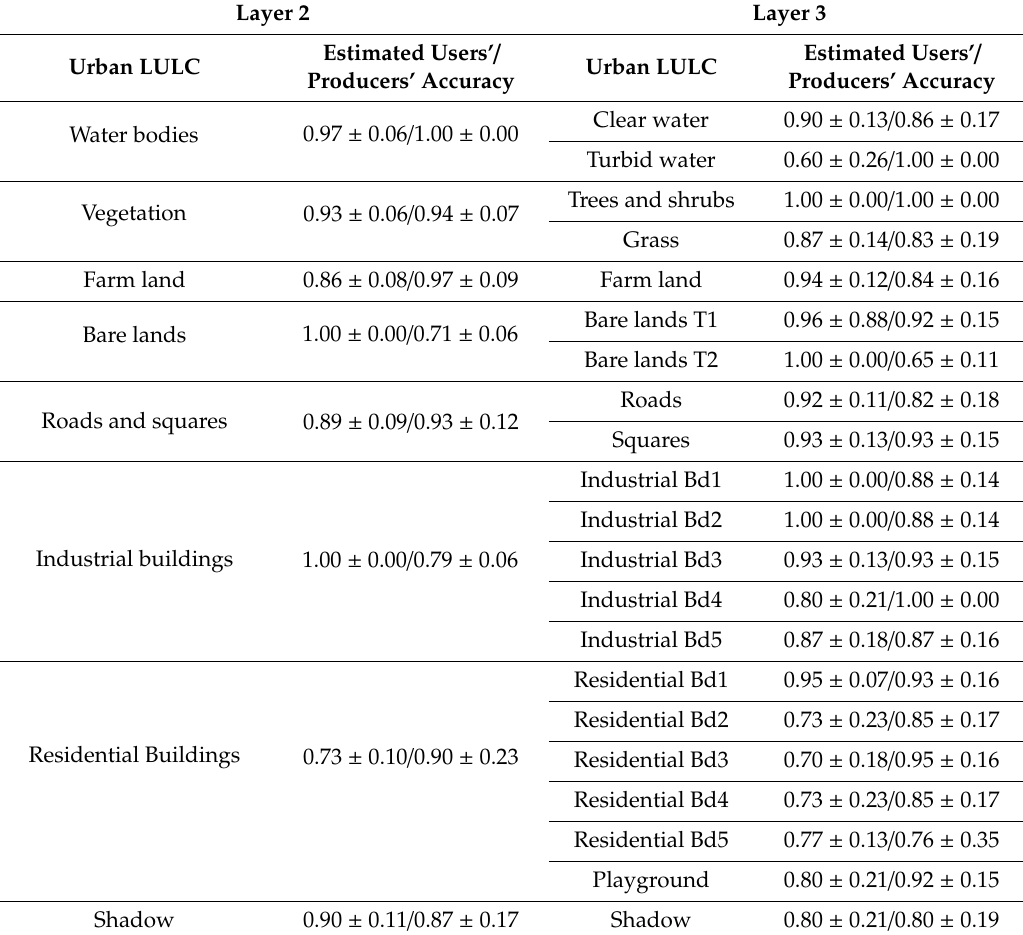
Table 7. The estimated user’s accuracy with a 95%